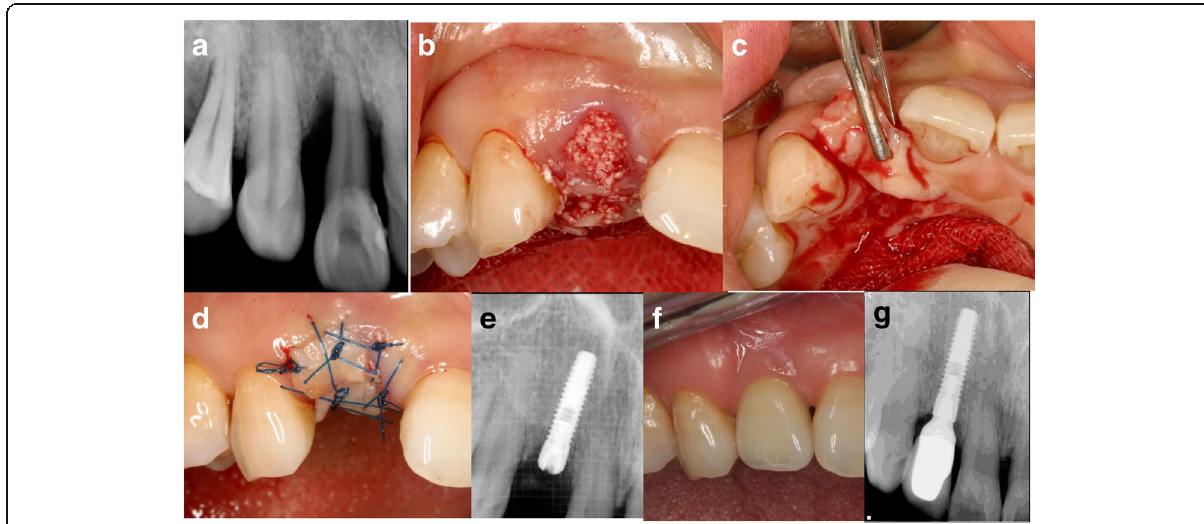
Fig. 2 Socket sealing using a pedicled palatal gingival graft. a The first periapical view. b Extraction and bone graft. c , d Pedicled palatal flap. e Periapical radiograph after implant placement. f Intraoral view 58 months after final prosthesis placement. g Periapical radiograph 93 months after final prosthesis